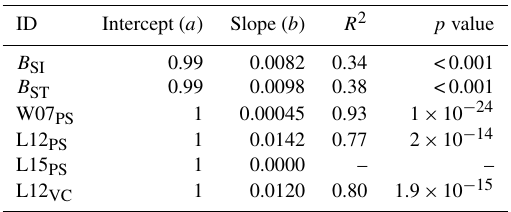
Table A3. Slopes and intercepts of biomass dose–response relation- ships for broadleaved species simulated by O-CN versions based on published injury functions to net photosynthesis or V cmax (see Table 1). B SI and B ST represent the simple and standard model of Büker et al. (2015). A dash (“–”) indicates that no values were avail- able.